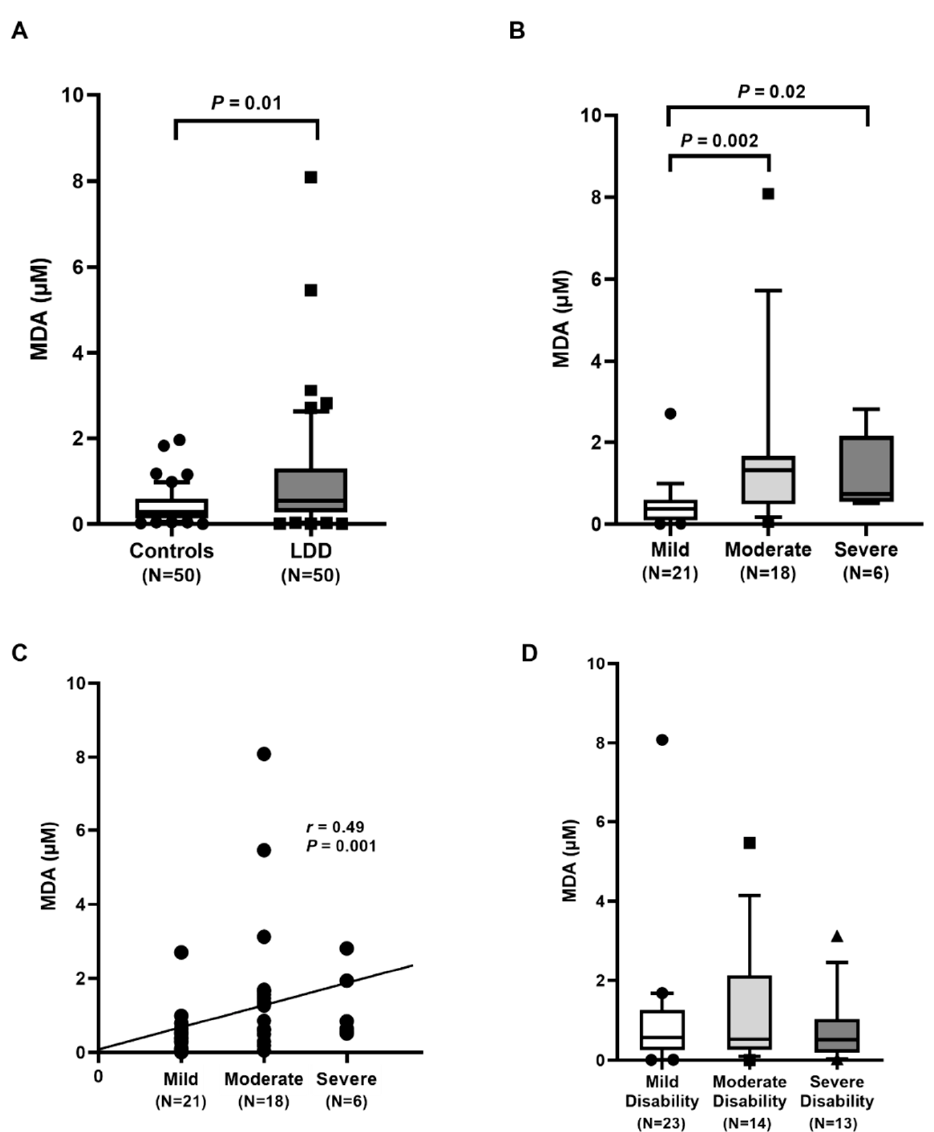
Figure 2. Determination of malondialdehyde (MDA) concentration: ( A ) comparison of MDA con- centration in lumbar disc degeneration (LDD) patients and controls. Circles represent control group, squares LDD group; ( B ) comparison of MDA concentration in LDD, based on the radiographic severity. Circles represent mild group, squares moderate group; ( C ) correlation of MDA concentration and the severity. Circles represent individual data points; ( D ) comparison of MDA concentration in LDD, stratified by Oswestry disability index score. Circles represent mild group, squares moderate group, triangles severe group.